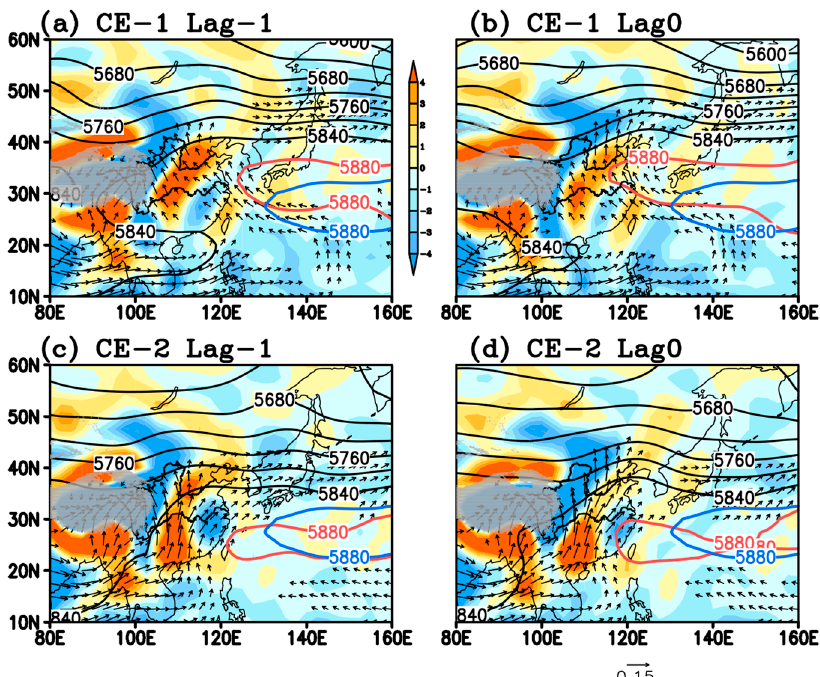
Figure 7. Composites of the 850 hPa water vapor transportation (vector, units: m·kg·s − 1 ·kg − 1 ) and divergence (colored shading, same for all subplots, units: kg·s − 1 ·kg − 1 ) and of 500 hPa geopotential height (black contour, units: gpm) at Lag − 1 day ( a , c ) and Lag 0 day ( b , d ) for the REP events in CE-1 ( a , b ) and CE-2 ( c , d ). The 5880 gpm contour and the climatologic July and August mean 5880 gpm contours are highlighted as a thick red line and thick blue line, respectively. The gray shaded areas indicate elevations > 3200 m.